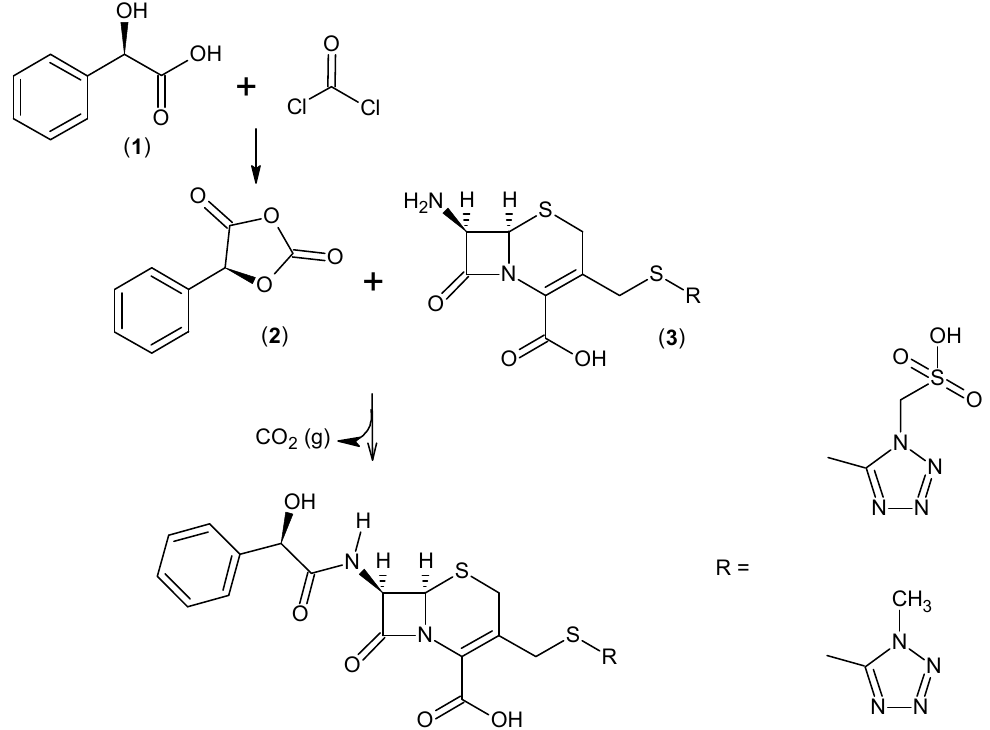
Figure 2. Amidation of OCA ( 2 ) from ( R )-mandelic acid ( 1 ) and 7-SACA or 7-TACA intermediate ( 3 ). The synthesis of this compound in β -lactam manufacturing ( 2 ), from phosgene or its derivatives (di- and triphosgene) [38–44], has always been limited by safety and envi- ronmental concerns. In addition, the racemization caused by the hydrochloric acid that is released during mandelic cyclization means that several purification steps must be performed if the R form is to be obtained, making the process poorly